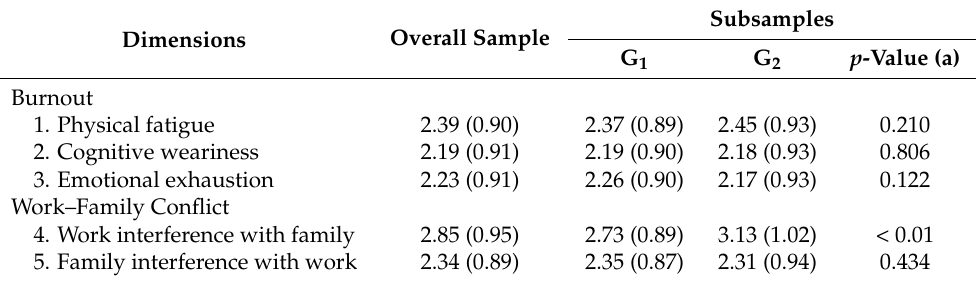
Table 1. Mean and standard deviation for burnout and work–family conflict dimensions. Dimensions Overall Sample